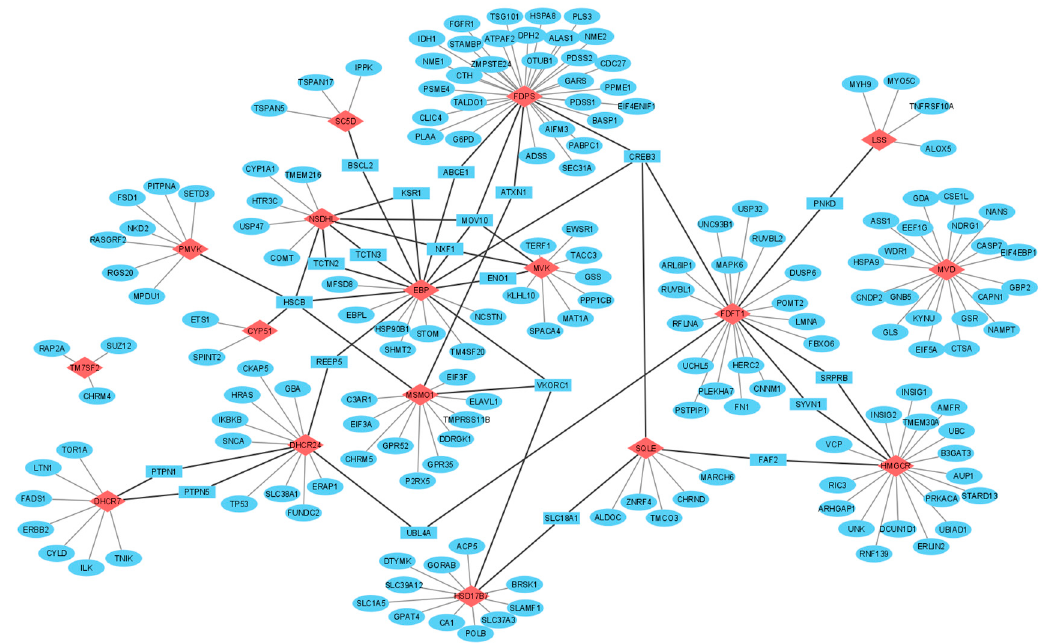
Figure 4. Network construction of PPIs involving the cholesterol synthesis enzymes. Legend: target enzymes, unique and common protein partners are shown in red diamonds, blue ellipses and blue rectangles, respectively. Edges, connecting enzymes through common protein partners, are highlighted in bold.